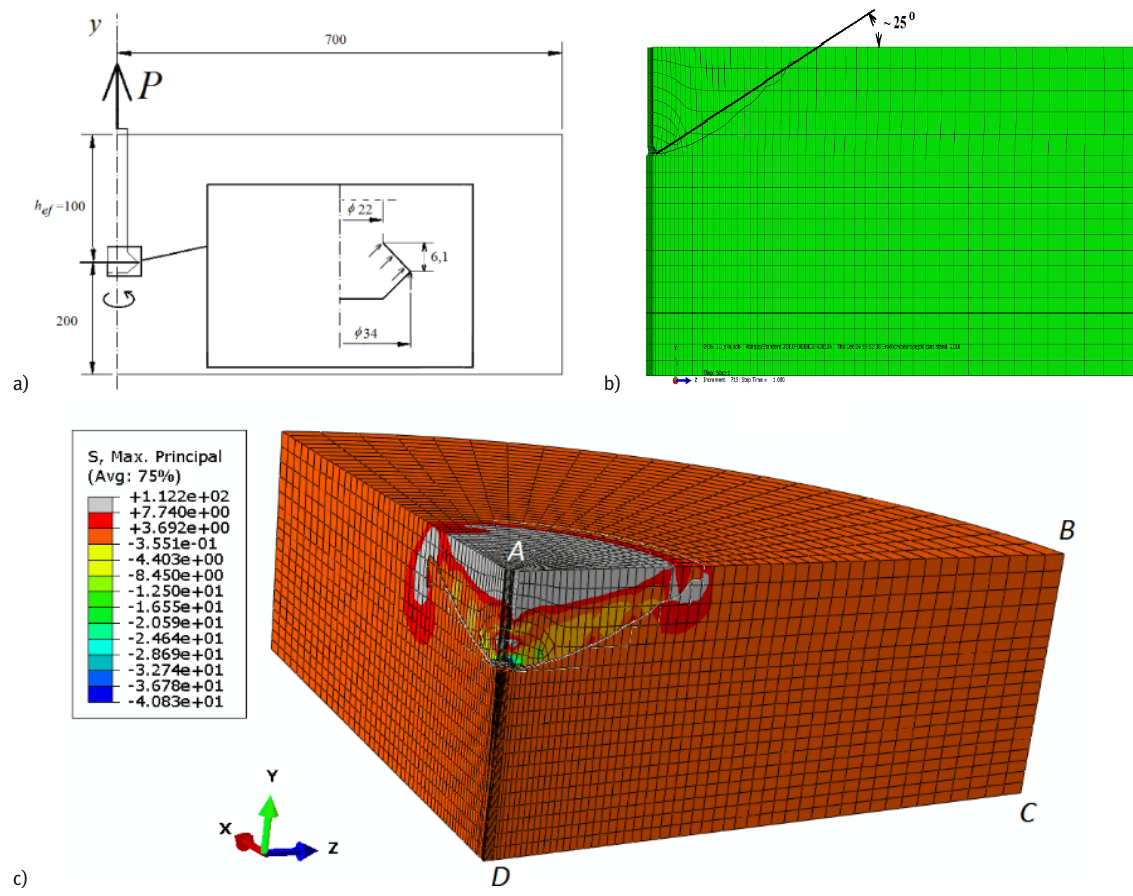
Figure 7. Computer simulations [14]: a) scheme of the task, b) the average value of the angle of the concrete cone failure (section plane ABCD in Figure 7c), c) maximal principal stress distribution and crack propagation path in the FEM model (a quarter of the model). FEM, finite element